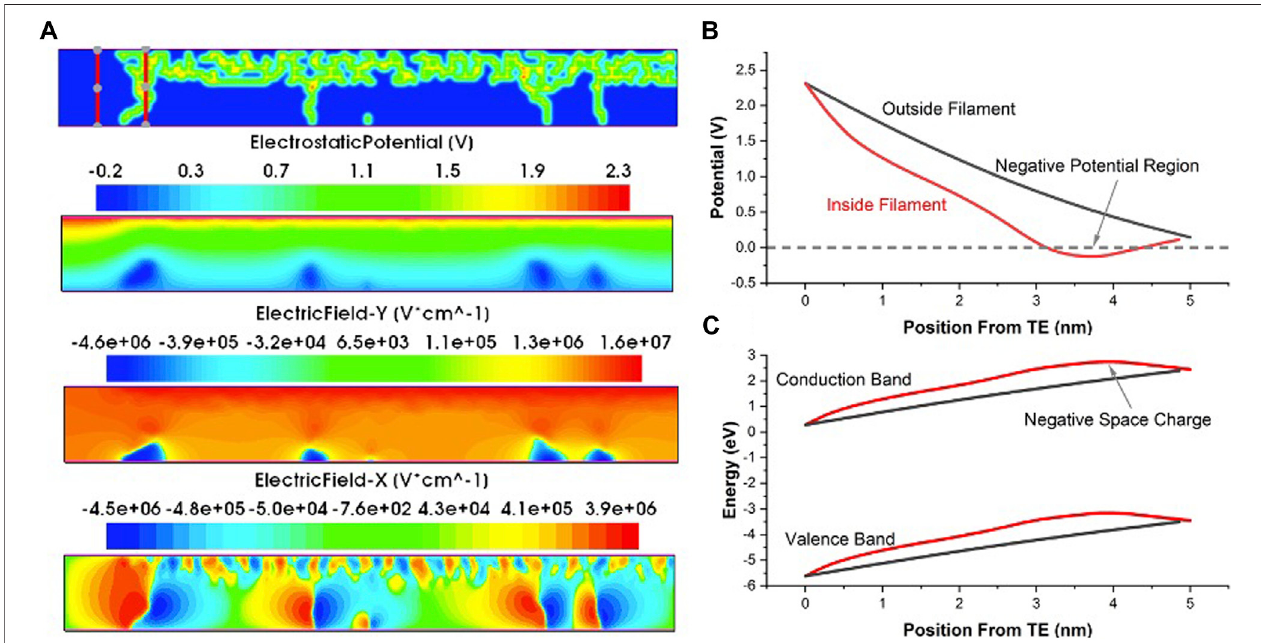
FIGURE 8 | (A) Filament electrostatics after forming, including the electrostatic potential, and electric fi eld components. (B) Comparison of electrostatic potential inside and outside of a fi lament region as indicated in the red lines in (A) . The fi lament region shows a region of negative potential and can be likened to a “ negative potentialsynapse. ” (C) Comparisonoftheenergybanddiagraminsideandoutsideofthe fi lament.Withinthe fi lament,anegativecurvatureindicatesthatthe fi lamentisa negative space-charge